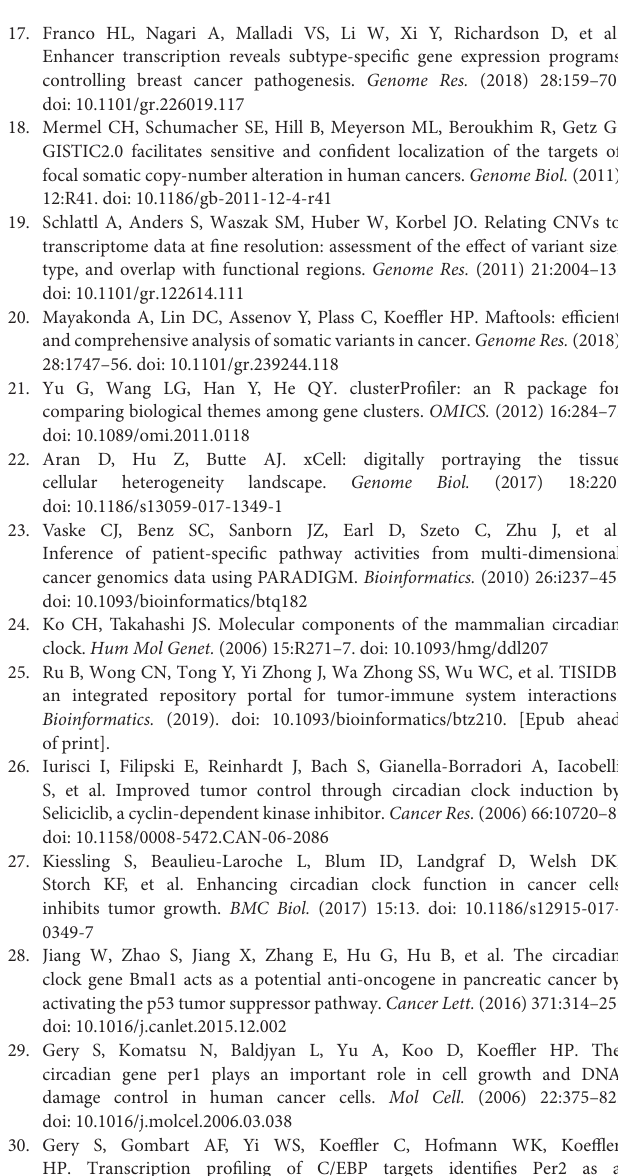
Table S1 | List of core circadian clock genes. Table S2 | Patient characteristics used for analysis. Table S3 | Abbreviations of cancer types and datasets used for analysis. Table S4 | Open resource download link used for